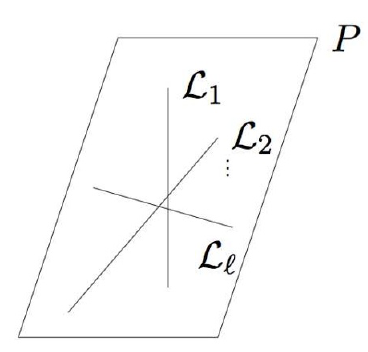
Figure 4 . All in plane